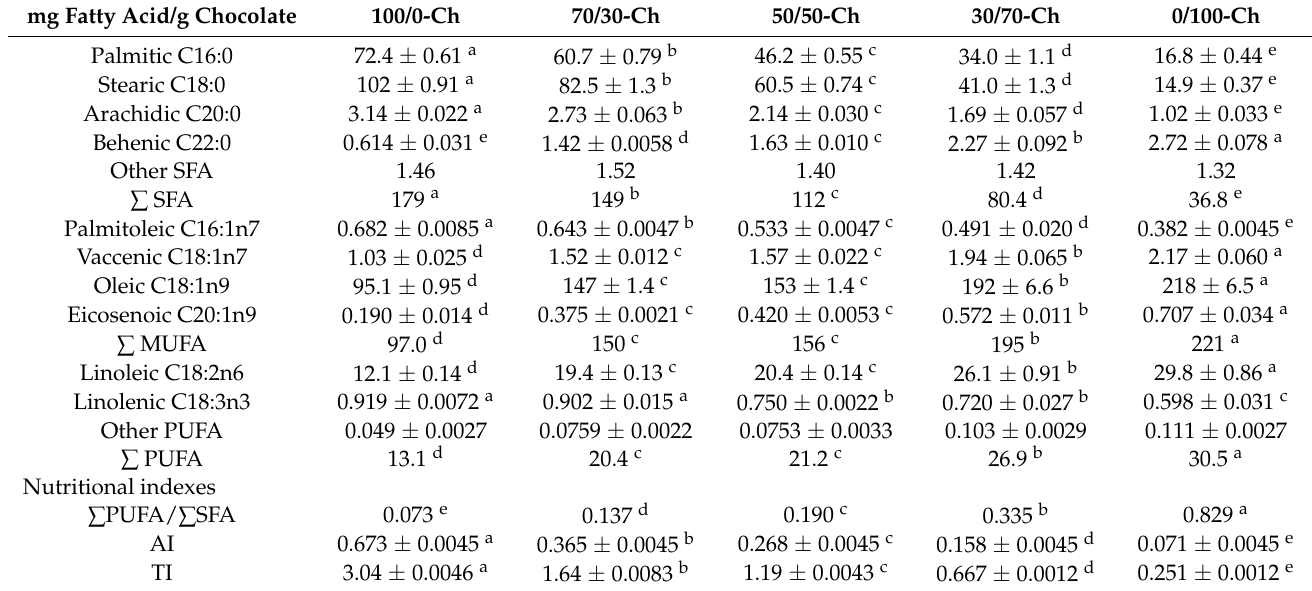
Table 1. Lipid profile corresponding to the different formulated CB/OG-based chocolates (CB/OG-Ch). mg Fatty Acid/g